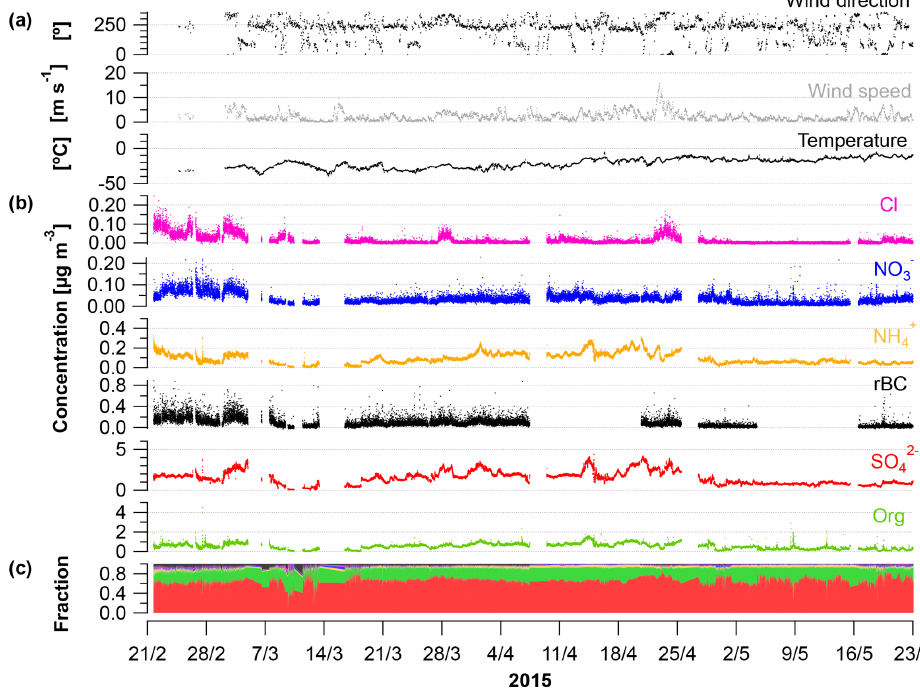
Figure 1. Time series from 21 February to 23 May 2015 showing (a) wind direction ( ◦ ); mean wind speed (ms − 1 ) and temperature ( ◦ C); (b) concentrations of Cl, NO − , NH + , rBC, SO 2 − , and OA from the SP-AMS (µgm − 3 ); and (c) fraction of the aerosol species to the total 3 4 4 PM 1